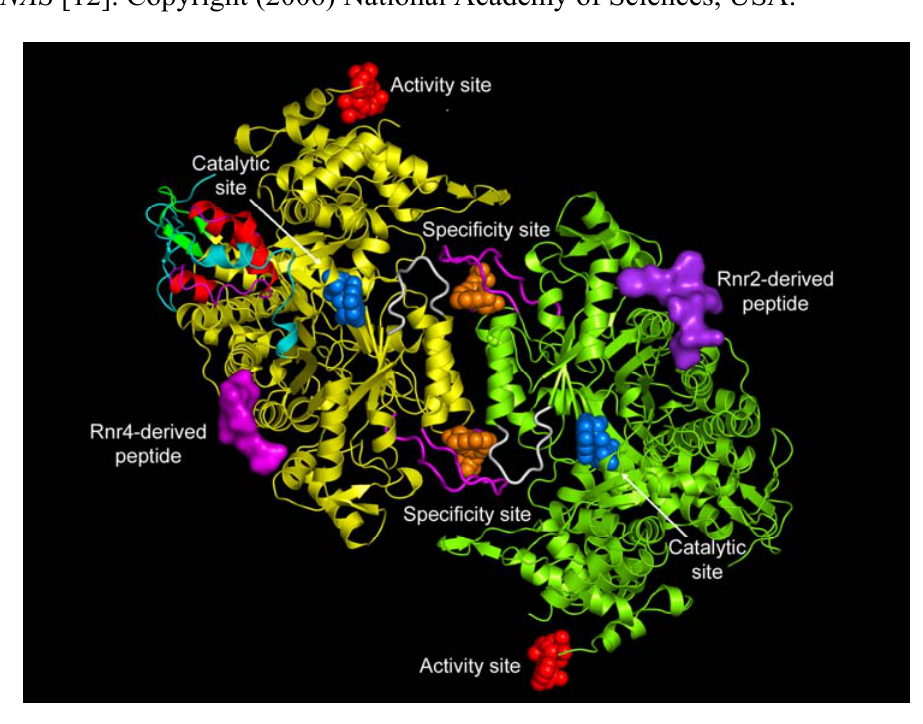
Figure 1. Class I Ribonucleotide reductase I. The specificity (S-site), catalytic (C-site), and activity (A-site) are shown as solid objects. Rnr2/Rnr4 peptides define the P-site. Loop 2 (white) and loop 1 (magenta) are close to the dimer interface. Reproduced with permission from PNAS [12]. Copyright (2006) National Academy of Sciences,